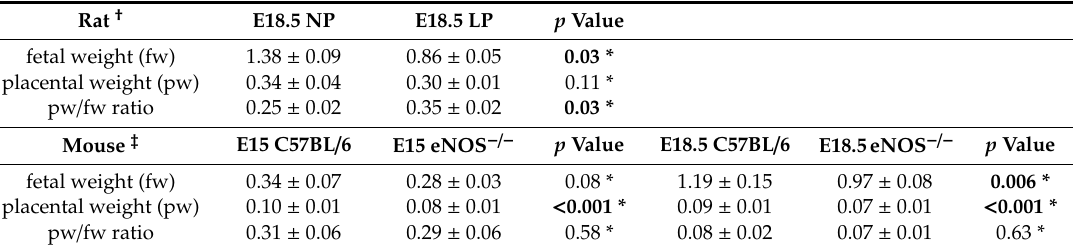
Table 1. Animal auxology. NP: normal protein diet; LP: low protein